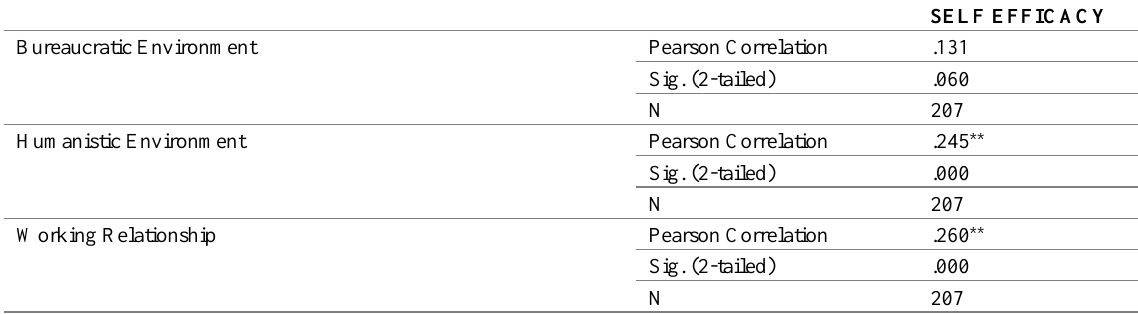
Table 11: Relationship between Work Environment and